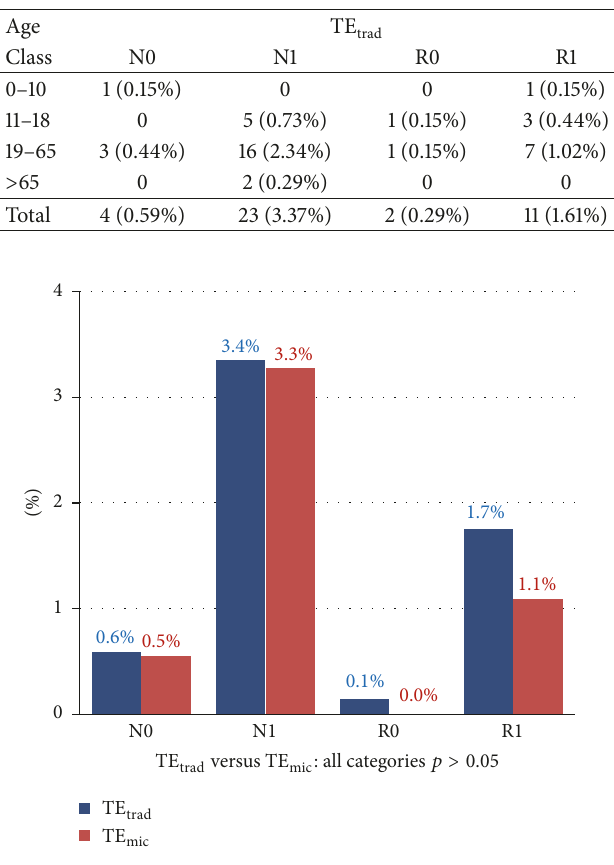
Figure 3: Rates of posttonsillectomy hemorrhage according to the time of bleeding and the need for surgical control (all 𝑝 > 0.05 ).